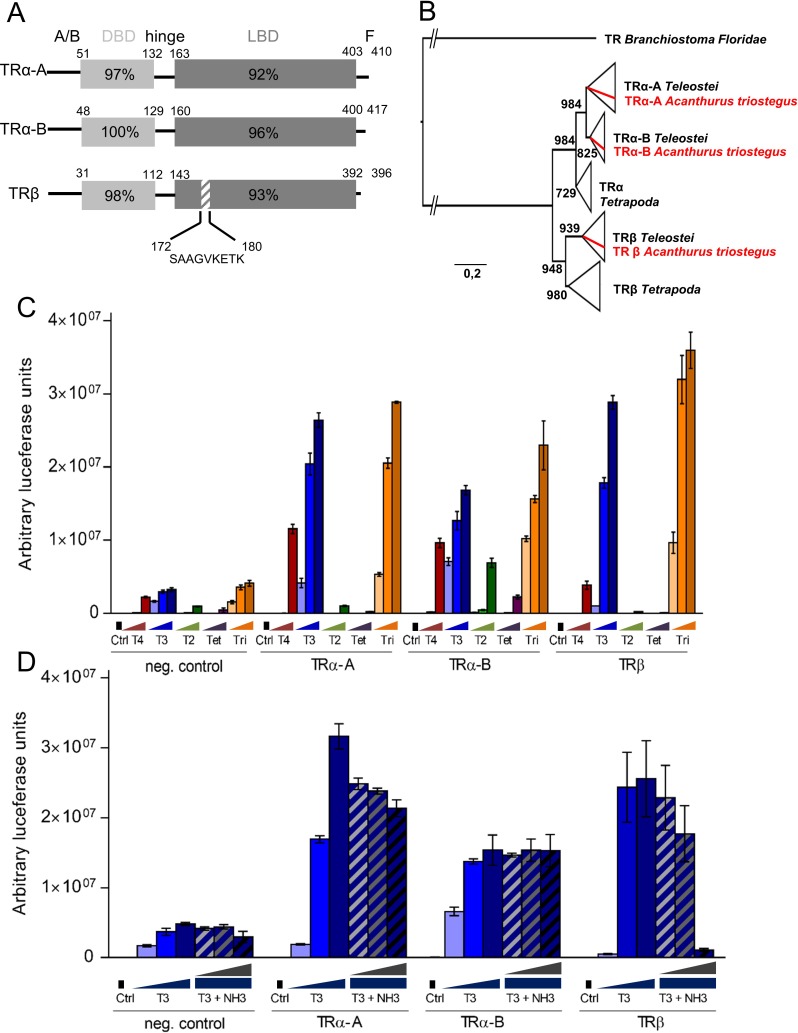
Characterization of Acanthurus triostegus thyroid hormone receptors.(A) Schematic representations of TRα-A, TRα-B and TRβ from upper to lower rows respectively. The amino acid numbering of the DBD (light gray) and LBD (dark grey) appear above each TR. The nine amino acid insertion of the TRβ long isoform is indicated below the gray dashed area. (B) Phylogenetic reconstruction of TR amino acid sequenced by maximum likelihood. Bootstrap over supporting each branches are indicated when >700/1000. A. triostegus genes are highlighted in red. (C) Transactivation assay of TRs in HEK293T cells with a luciferase reporter. X-axis: Tested genes and treatment condition. T4: blue bars, T3: red bars, T2: green bars, Tetrac: purple bars and Triac: orange bars. The concentrations range from 10−9 M to 10−7 M which corresponds to the light and dark shade of each color. Tested genes are indicated on the bottom line. Y-axis: arbitrary luciferase unit. Three technical replicates were performed. See Figure 2—source data 4 for detailed data. (D) Transactivation assay of TRs in HEK293T cells with a luciferase reporter. X-axis: tested genes and treatment conditions. Light blue to dark blue bars: T3 treatments at 10−9, 10−8, and 10–7 M respectively. Light blue to dark blue dashed bars: T3 + NH3 treatments with T3 at 10−8 M and NH3 at 10−8, 10−7 and 10−6 M respectively. Y-axis: arbitrary luciferase unit. Three technical replicates were performed. See Figure 2—source data 5 for detailed data.